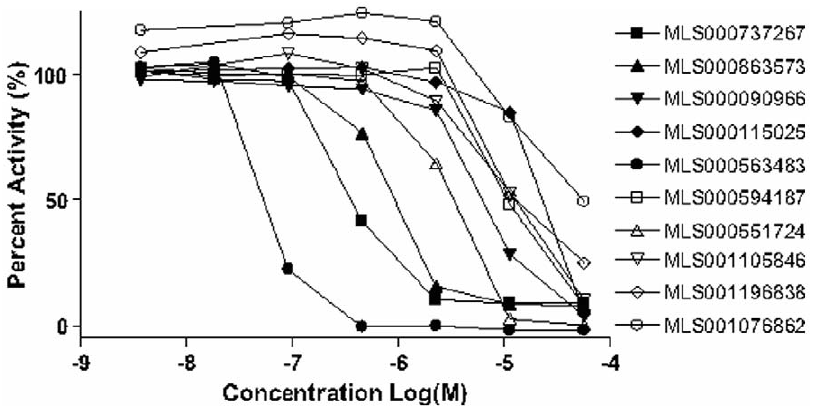
Figure 2. Representative curves observed from 10 screening hits chosen to demonstrate the range of potencies observed in the concentration-response-based screen. Structures and additional data associated with these hits are presented within Figure 7.